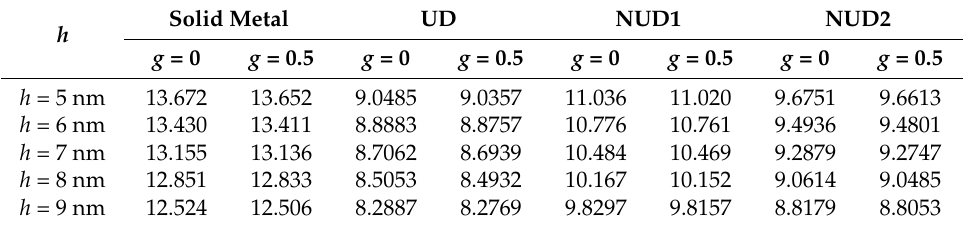
Table 5. The non-dimensional critical buckling loads with different thicknesses, small scale parameters and porosity distributions of rectangular nanoplate ( l a = 50 nm, l b = 75 nm, m = n = 1, ζ = 1, λ = 0.5).